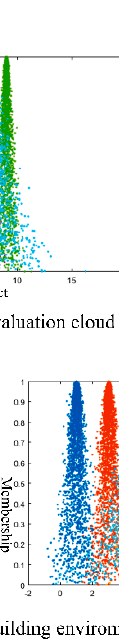
Figure 6. Guideline layer index evaluation cloud.